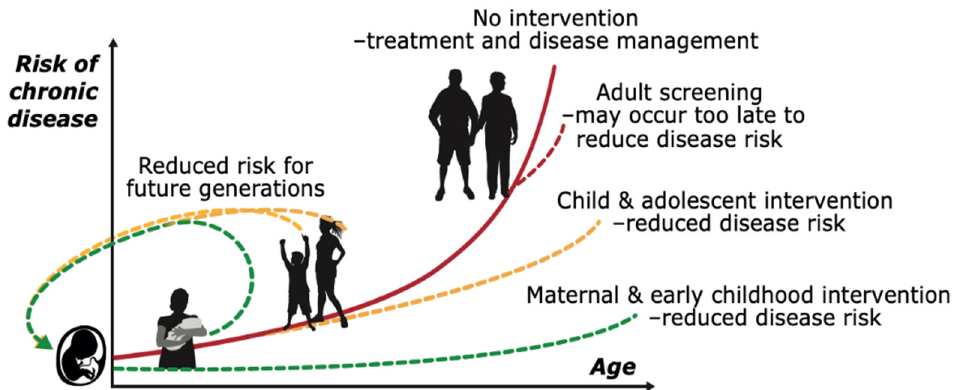
Figure 1. The power of early intervention. Developmental origins of metabolic disease: lifecourse and intergenerational perspectives. The lifecourse approach emphasizes the complex interactions between environmental exposures from pre-conception onwards that influence chronic disease risk. NCD risk increases throughout the lifecourse and as such NCDs do not fit the typical disease model in which an individual is healthy until they contract a disease. The greatest period of developmental plasticity and therefore responsiveness to interventions is in early life. As ageing occurs, responses to new challenges become increasingly inadequate. As such interventions are best timed in early life—although these require a long-term commitment, they are likely to return greater impacts on NCD prevalence than treatment of disease once already manifest. Such an approach also helps mitigate the potential for transgenerational transmission of disease traits. Although an initial focus was on mothers and infants, and more recently on paternal health, there is an increasing recognition of adolescents, as the next generation of parents, as a key lifecourse window of opportunity to break the DOHaD cycle. Adapted with permission from Godfrey et al . [21].